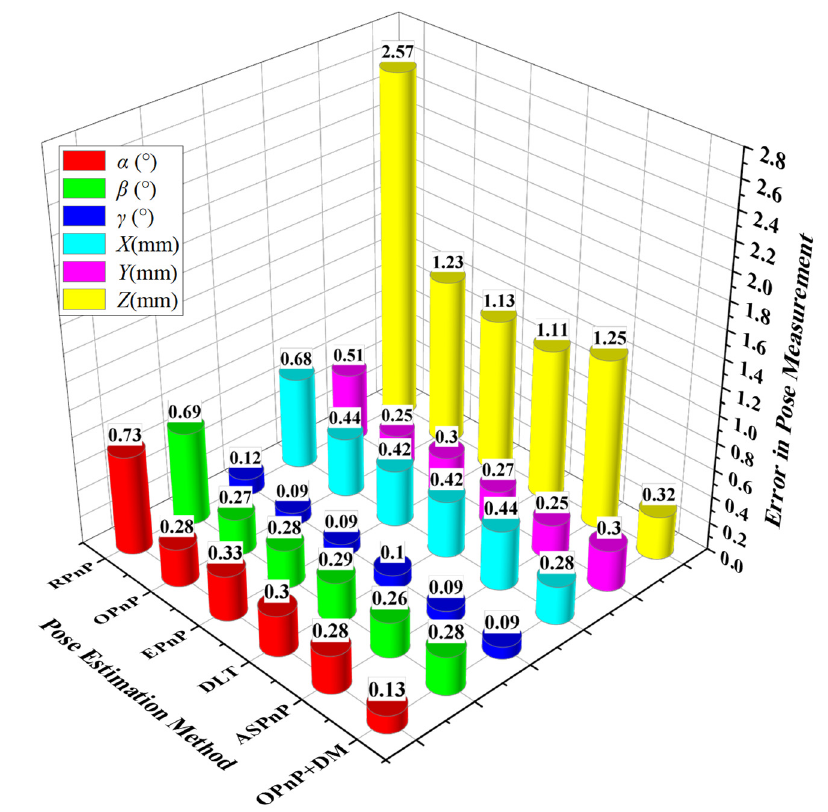
Figure 10. Standard deviation of pose error.